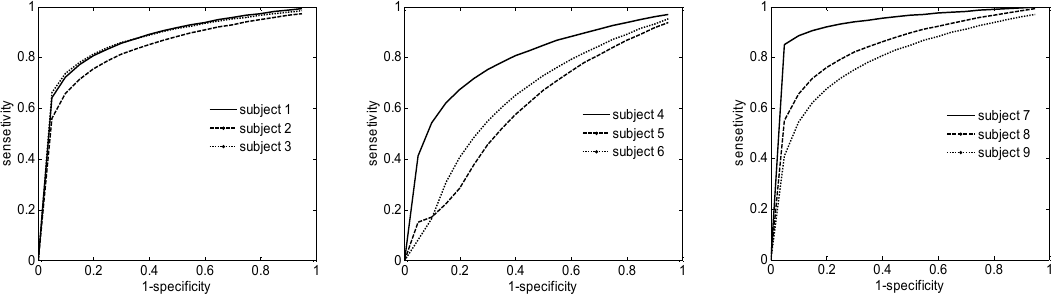
Figure 6. ROC curve analysis for IIa Data set using the best classification results.